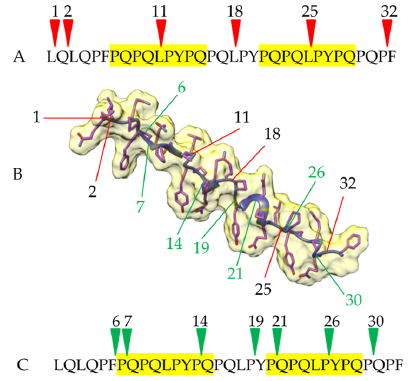
Figure 9. ( A ). Potential cleavage sites for pepsin (numbered red arrows) predicted along the amino acid sequence of the 26 mer peptide derived from α -gliadin. ( B ). Three-dimensional model in the extended conformation built for the 33 mer peptide, showing the exposure of the potential cleavage sites for pepsin (numbered red lines). ( C ). Potential cleavage sites polyl peptidases predicted along the amino acid sequence of the 33 mer peptide. The two potential celiac peptides of the 33 mer peptide are highlighted in yellow.